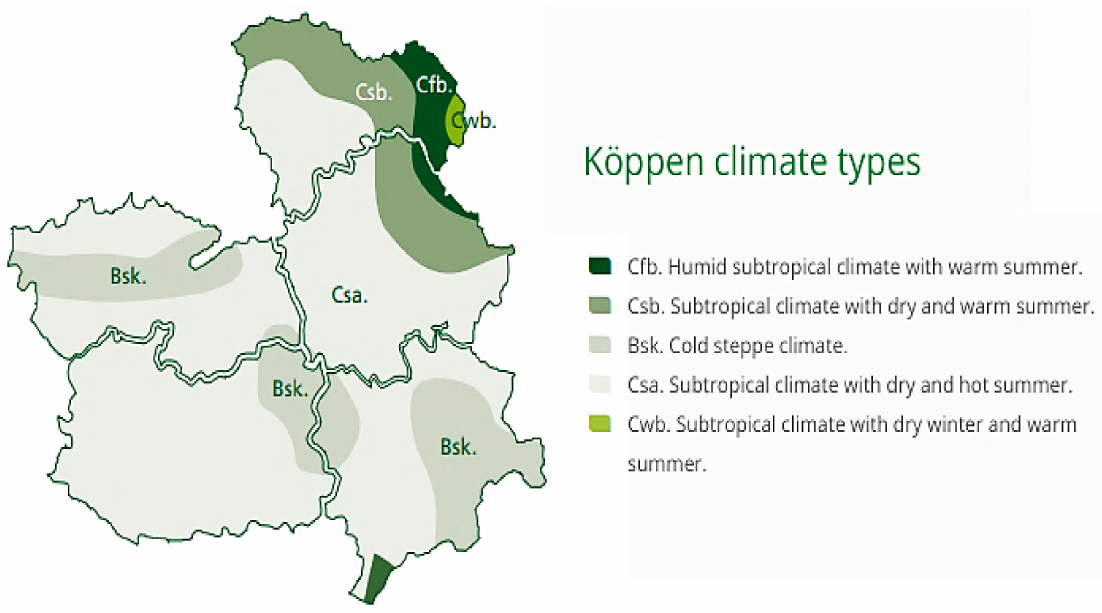
Figure 5. Climatic regionalization based on Köppen’s classification (adapted from